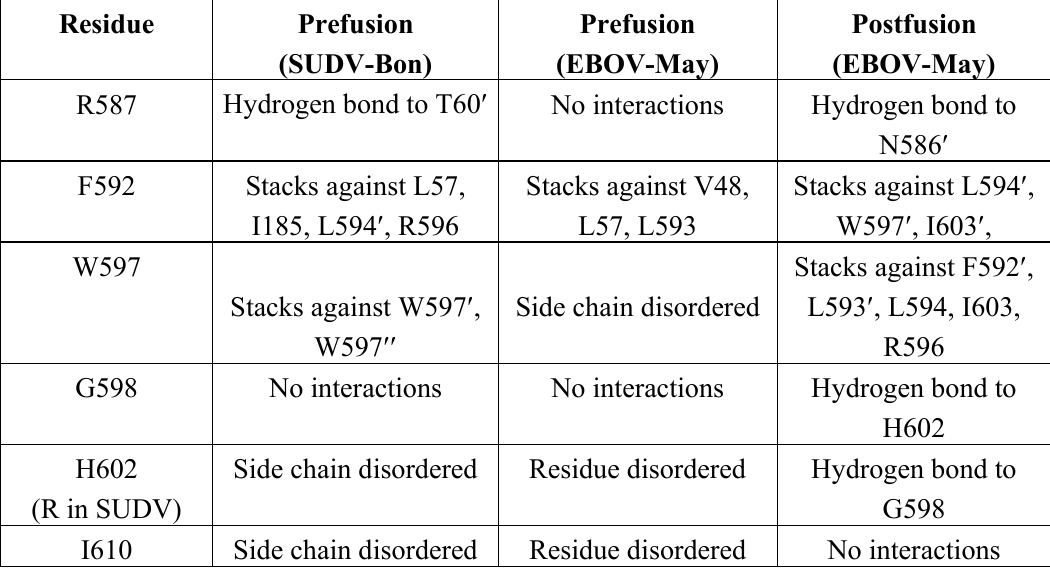
Table 2. Interactions between SUDV GP